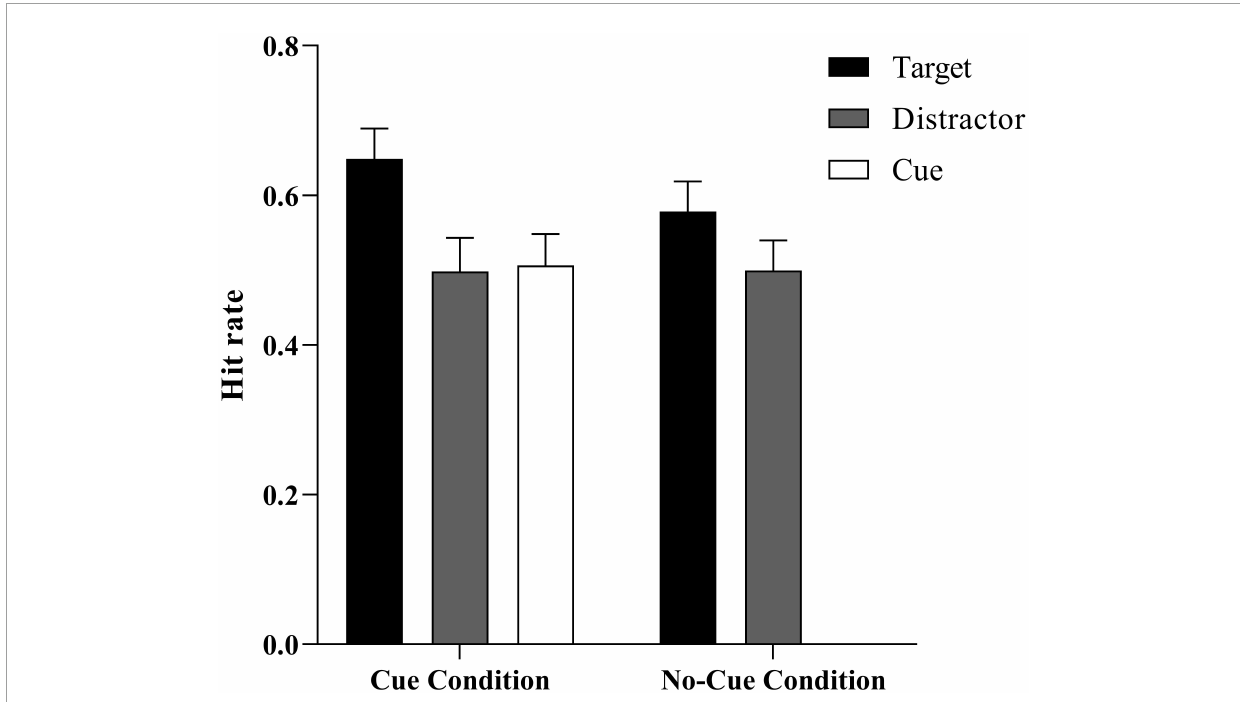
FIGURE2 Mean hit rate as a function of stimulus type (target vs. distractor vs. cue) × condition (cue vs. no-cue). Error bars represent ± 1 SE of the